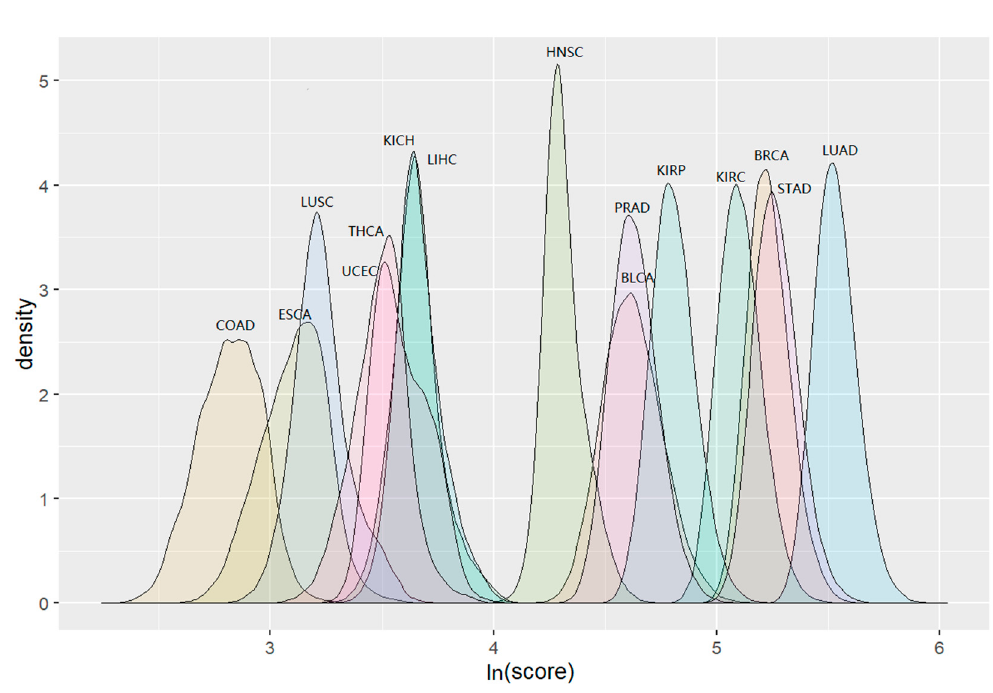
Figure 4. The distribution of cluster scores with max score values when running Louvain algorithm 10,000 times for 15